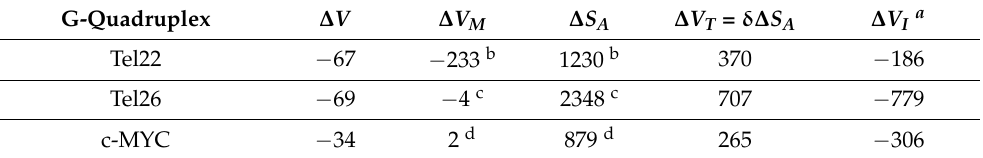
Table 2. Changes in volume, ∆ V (cm 3 mol − 1 ), determined at 25 ◦ C, intrinsic volume, ∆ V M (cm 3 mol − 1 ), solvent accessible surface area, ∆ S A ( Å 2 ) , thermal volume, ∆ V T (cm 3 mol − 1 ), and interaction volume, ∆ V I , accompanying G-quadruplex unfolding transitions. G-Quadruplex ∆